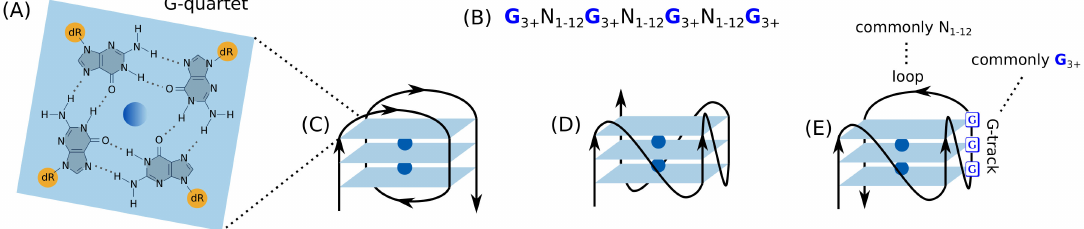
Figure 1. The structure and topologies of G4. ( A ) Structure of a G-quartet formed by hydrogen bonded four guanines and central cation (blue). ( B ) The consensus sequence of G4. Representative topologies of unimolecular G4s based on the strand direction: ( C ) antiparallel, ( D ) parallel, and ( E )